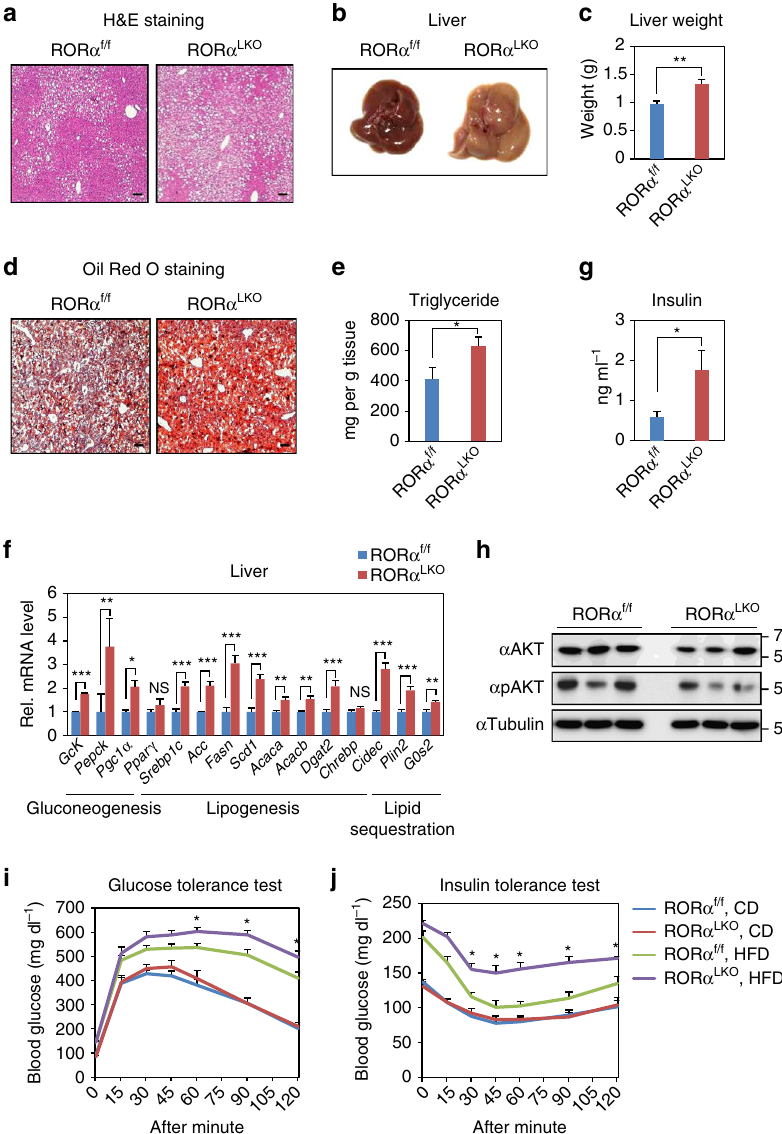
Fig. 2 Liver-speci fi c Ror α deleted mice are susceptible to diet-induced hepatic steatosis and insulin resistance. a – j ROR α f/f and ROR α LKO mice were fed with HFD for 10 weeks. a Representative liver histological section images of ROR α f/f and ROR α LKO mice stained with hematoxylin and eosin. Scale bar, 100 μ m. b Macroscopic view of livers from ROR α f/f and ROR α LKO mice. c Liver weights of ROR α f/f and ROR α LKO mice ( n = 10 – 11 per group). d Representative liver histological section images of ROR α f/f and ROR α LKO mice stained with Oil Red O. Scale bar, 100 μ m. e Triglyceride content of livers from ROR α f/f and ROR α LKO mice ( n = 8 per group). f Hepatic gene expression pro fi le involved in metabolism from the livers of ROR α f/f and ROR α LKO mice ( n = 4 per group) as determined by quantitative PCR with reverese transcription (qRT-PCR). Expression was normalized to 36B4 expression. g Fasting insulin levels in ROR α f/f and ROR α LKO mice ( n = 6 – 7 per group). Data expressed as mean ± s.e.m. Statistical analysis was performed using Student ’ s unpaired t -test. * P < 0.05, ** P < 0.01, *** P < 0.001, NS = non-signi fi cant. h Immunoblot analysis was performed from liver extracts of ROR α f/f and ROR α LKO mice. i ,